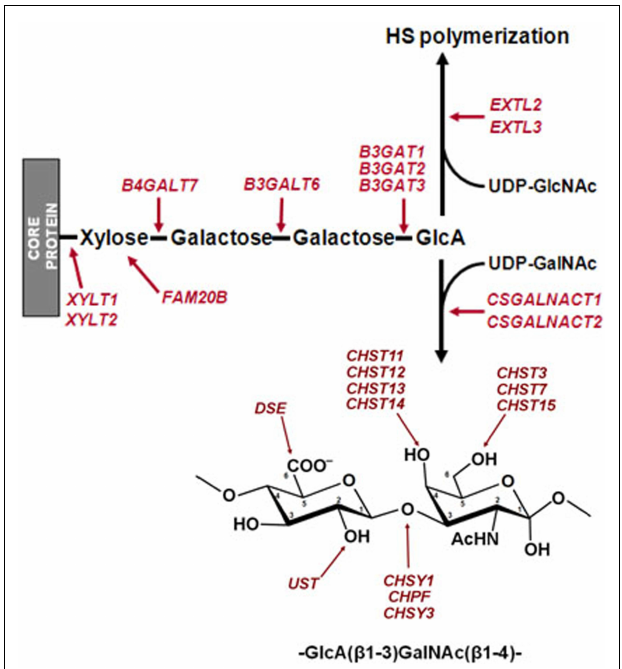
FIGURE 1 | Chondroitin sulfate and HS biosynthesis . Biosynthesis begins with the addition of a xylose to specific serine residues acceptor of a PG core protein. Subsequently, the biosynthesis continues with the stepwise addition of two galactose units, and a GlcA. HS chain extension requires the subsequent transference of a GlcNAc residue, while the addition of a GalNAc directs the pathway toward the biosynthesis of CS. Sites of action of the enzymes involved in the initiation of the synthesis of GAG chains and in the modification of the CS disaccharide unit are